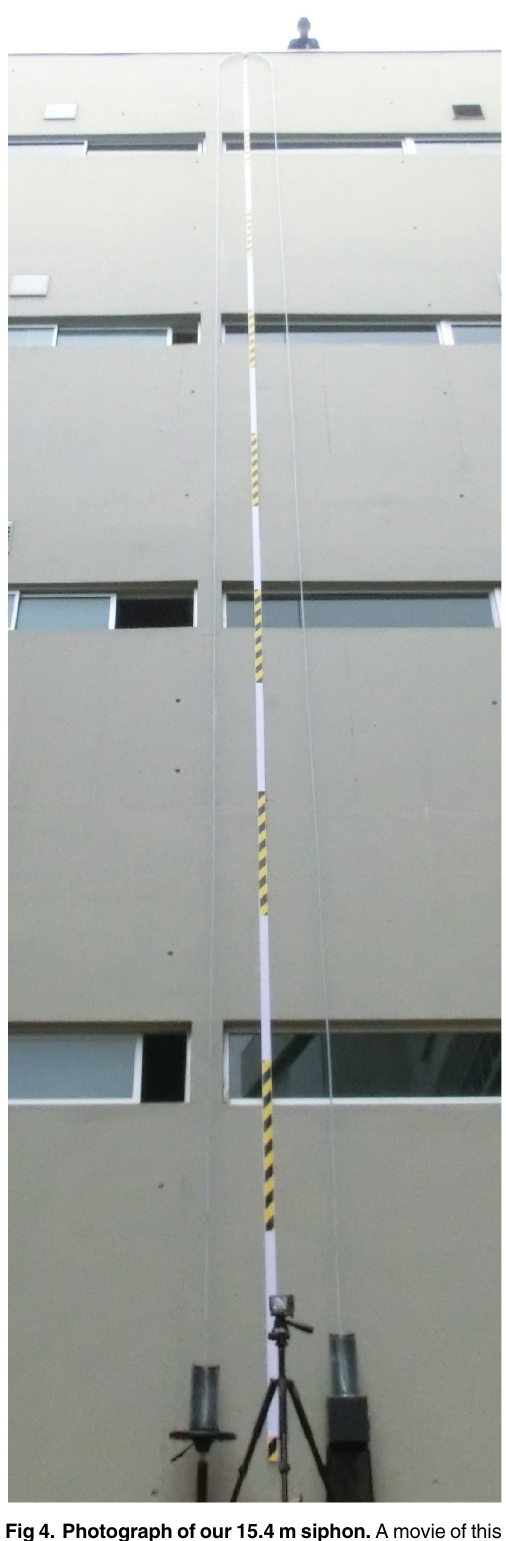
Fig 4. Photograph of our 15.4 m siphon. A movie of this experiment is available as supplementary material in the online version of the paper.